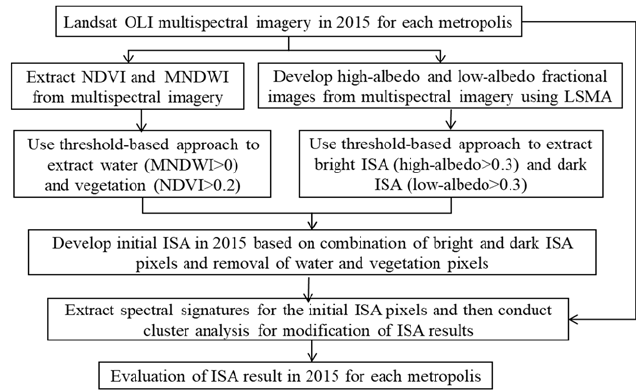
Figure 3. Flowchart for mapping impervious surface using the hybrid approach (note: NDVI and MNDWI represent Normalized Difference Vegetation Index and Modified Normalized Difference Water Index and LSMA represents linear spectral mixture analysis).